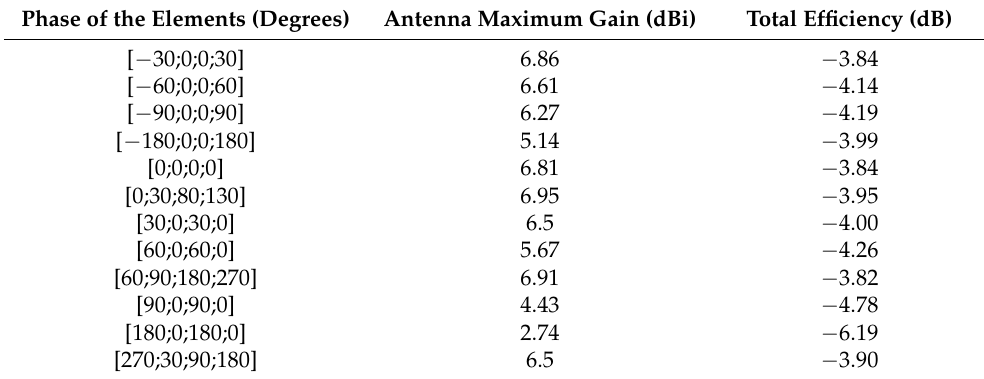
Table 1. The influence of the phase difference between the elements of the linear array 1 × 4 patch antenna on some significant parameters.